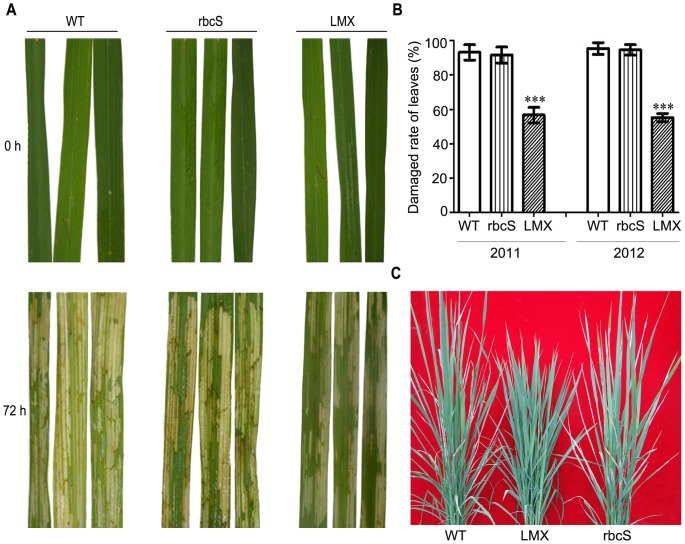
Leaves of the LMX transgenic rice plants demonstrate insect resistance.
A. Damage caused by rice leaf folder on the leaves of LMX transgenic rice plants. B. Ratio of the damaged leaf area to the whole leaf. C. Whole transgenic rice plants expressing LMX demonstrated improved resistance to rice leaf roller. Wild type plants and empty vector transgenic plants (rbcS plants) were used as the controls and homozygous LMX transgenic rice plants were used as the experimental group. Day 1 of 3rd instar rice leaf roller larvae were utilized in the bioassay. Leaves were photographed and measured after 72 h incubation with the rice leaf folder. Plants were photographed and measured after 7 days of incubation with the rice leaf folder larvae. Values are mean ± SD, *** denotes 0.001 significance value.